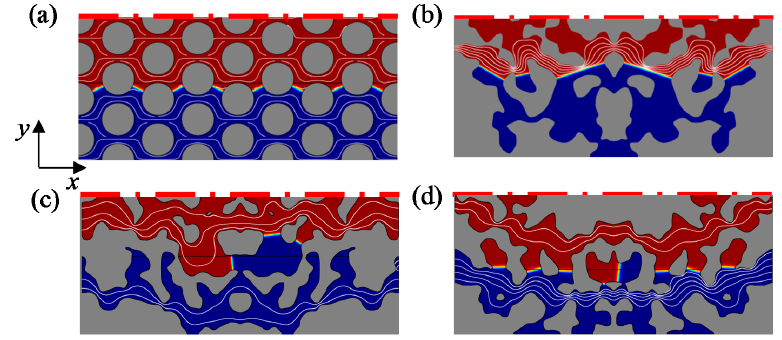
Figure 5. Distribution of the two phases (oil, in red; water, in blue) at steady state with θ = 90° for ( a ) HDa and S o = 0.42, ( b ) E1 and S o = 0.49, ( c ) E4 and S o = 0.50, and ( d ) E8 and S o = 0.49. Streamlines of the flow field are plotted as white curves.